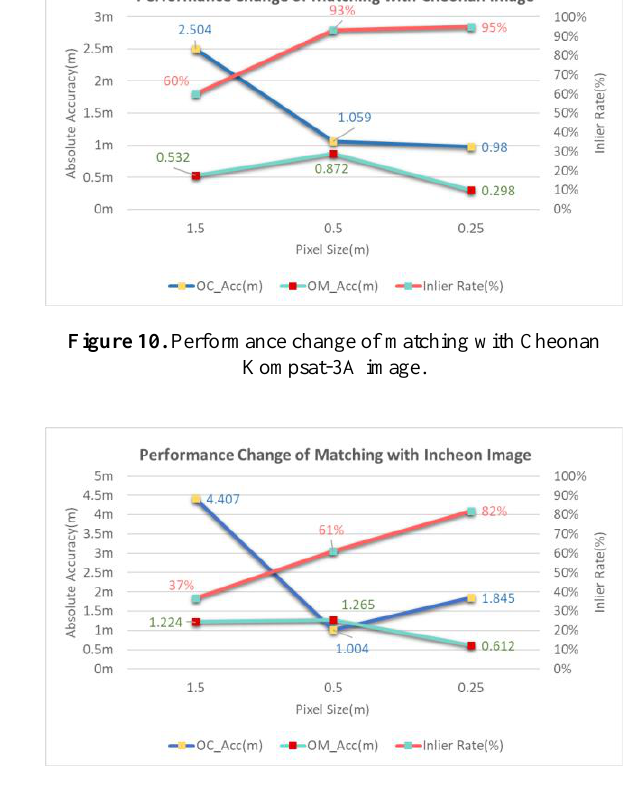
Figure 11. Performance change of matching with Incheon Kompsat-3A image.